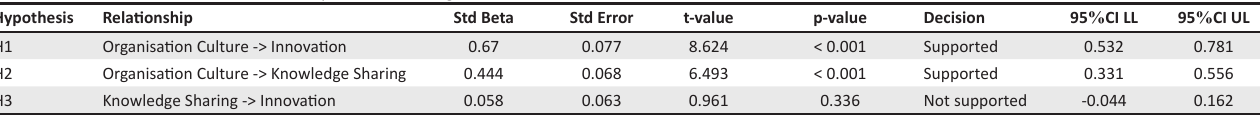
Knowledge Sharing ->